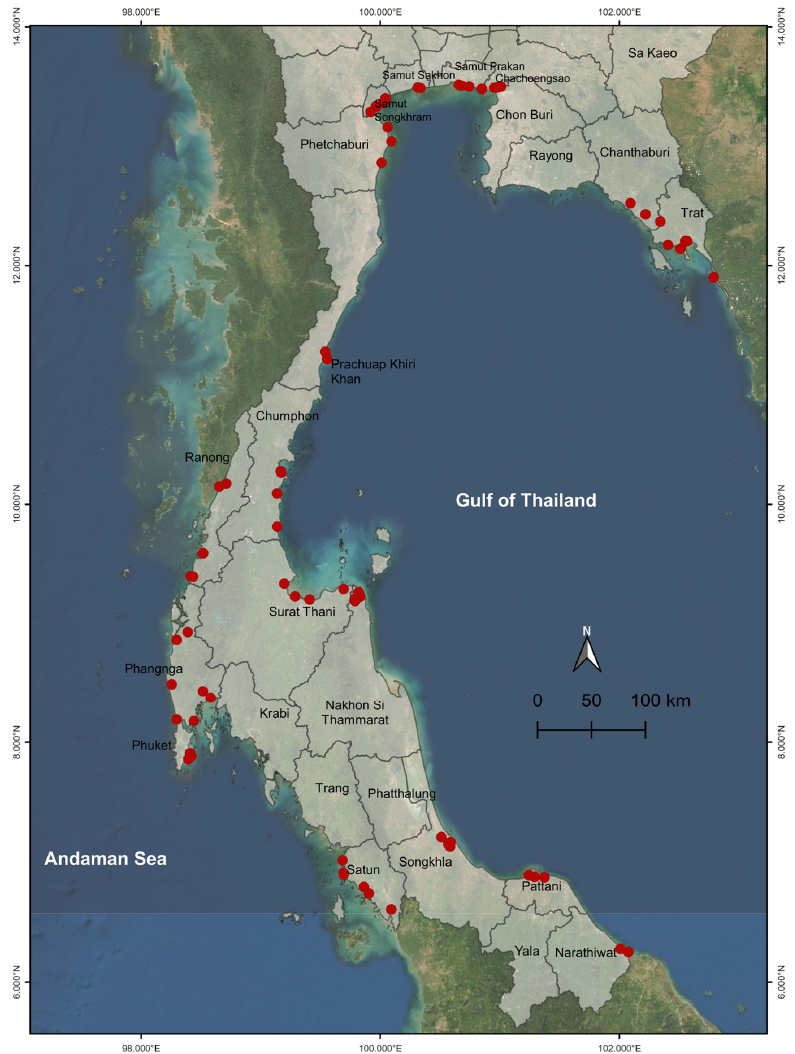
Figure 2. The geographical location of 80 R. mucronata accessions in Thailand. Collection sites in 18 provinces along the Andaman and Gulf of Thailand coasts in Thailand: Phetchaburi (PBI), Chantha- buri (CTI), Chachoengsao (CCO), Chumphon (CMP), Nakhon Si Thammarat (NST), Narathiwat (NWT), Phang-nga (PNA), Phuket (PKT), Prachuap Khiri Khan (PKN), Pattani (PTN), Ranong (RNG), Samut Sakhon (SKN), Samut Songkhram (SKM), Samut Prakan (SPK), Satun (STN), Surat Thani (SNI), Trat (TRT), and Songkhla (SKA). Red dots indicate collection sites at which the acces- sions were collected.